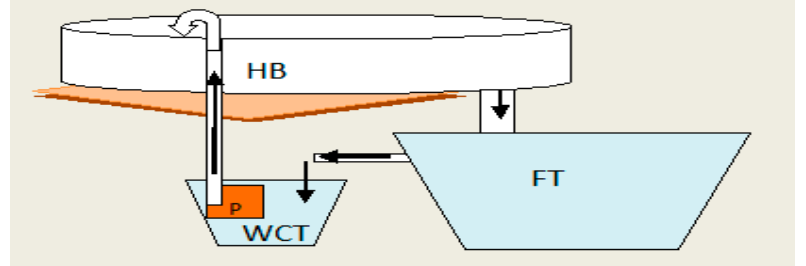
Figure 1. Diagram of the experimental units (the arrows show the direction of water flow); FT: Fish tank; WCT: Waste collection tank; HB: Hydroponic bed; P: Pump.